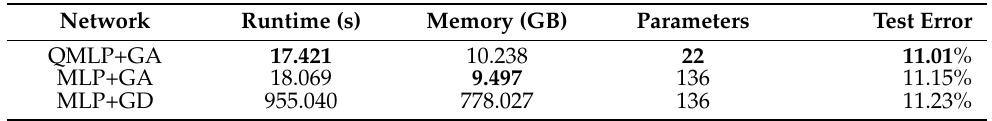
Table 3. Neural network comparison